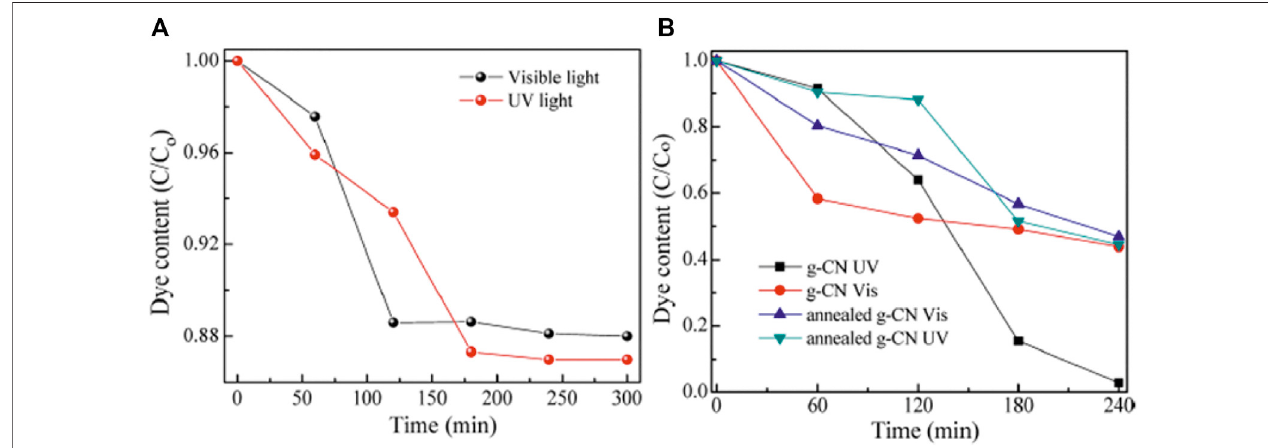
FIGURE17| Phodegradationef fi ciencyofMBwithout (A) andwith (B) biogenicallysynthesizedgraphiticcarbonnitride.The fi gureisreprintedwithpermissionfrom Tiwari and Ram, 2019 Copyright 2019, American Chemical Society.